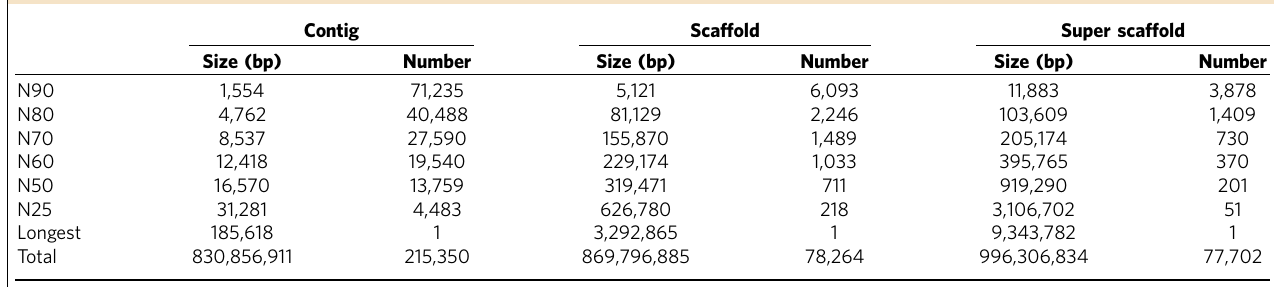
Only contigs and scaffolds Z 500bp were included in the genome